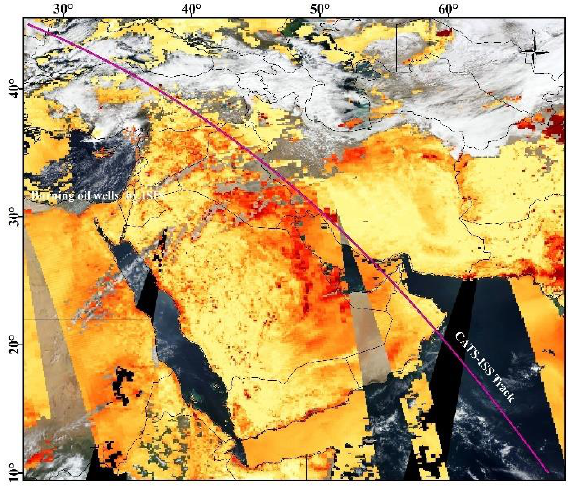
Figure 5. MODIS-AOD along with ISS-CATS orbit at